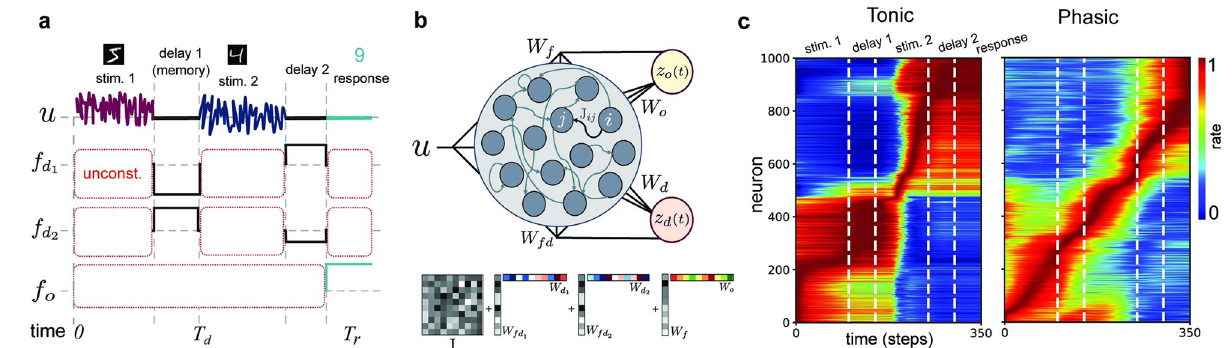
Fig 1. Optimizing RNN using modified FORCE to perform a sequential pattern matching (SPM) task. a , A single trial of a SPM task, wherein low- dimensional random process representations of handwritten digit stimuli are followed by short delay intervals. The network is optimized to generate the correct ‘summation’ output during a prescribed response interval. b , Schematic diagram of RNN architecture and low-rank structure added to initial connectivity J . After the network receives input trials sequentially via input weights, it encodes the memory representation z task outputs z o ( t ). We use a rank 2 structure for encoding memory and a rank 1 structure for generating response. c , Tonic and phasic activity for two different networks. Activity patterns (normalized) of neurons are sorted by the time of their peak